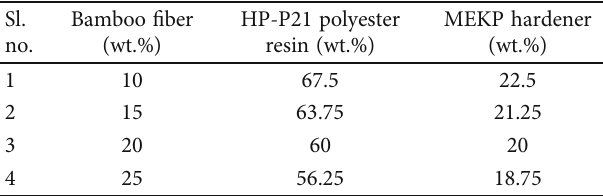
Table 2: Composition of the resin, hardener, and fi ber for synthesis of composites.